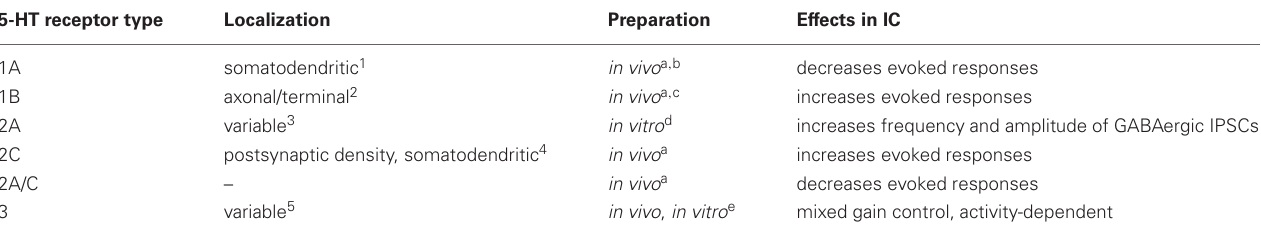
Table 1 | Summary of the effects of different serotonin receptor types in the IC.